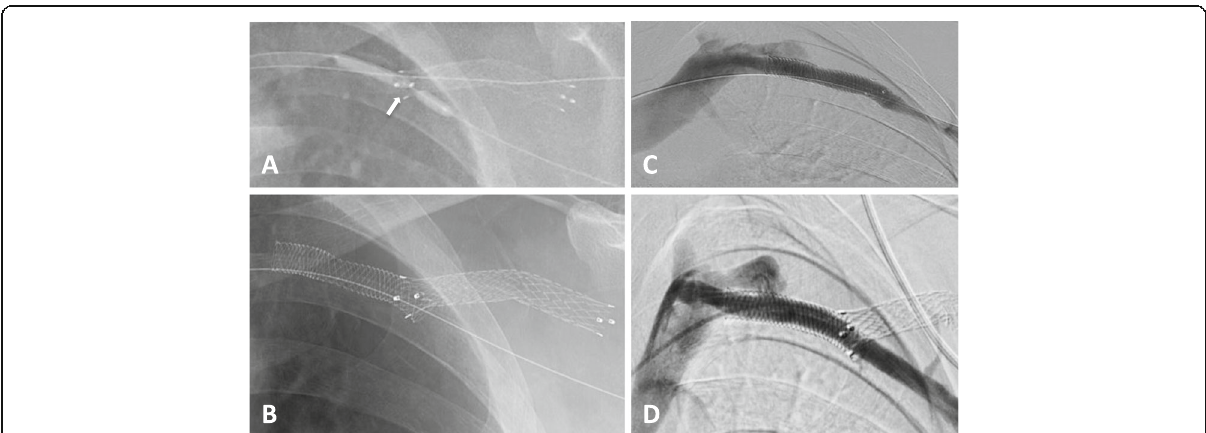
Fig. 6 a Fluoroscopic image showing focal ‘ wasting ’ of the pre-dilatation angioplasty balloon (arrow) through the stent wall. b Post Supera stent deployment showing satisfactory stent opening through the cephalic arch stent graft. c Antegrade venogram showing good flow through the Supera stent into the subclavian vein with no residual stenosis. d Retrograde venogram performed 6 months after stent deployment showing a widely patent Supera stent and axillary